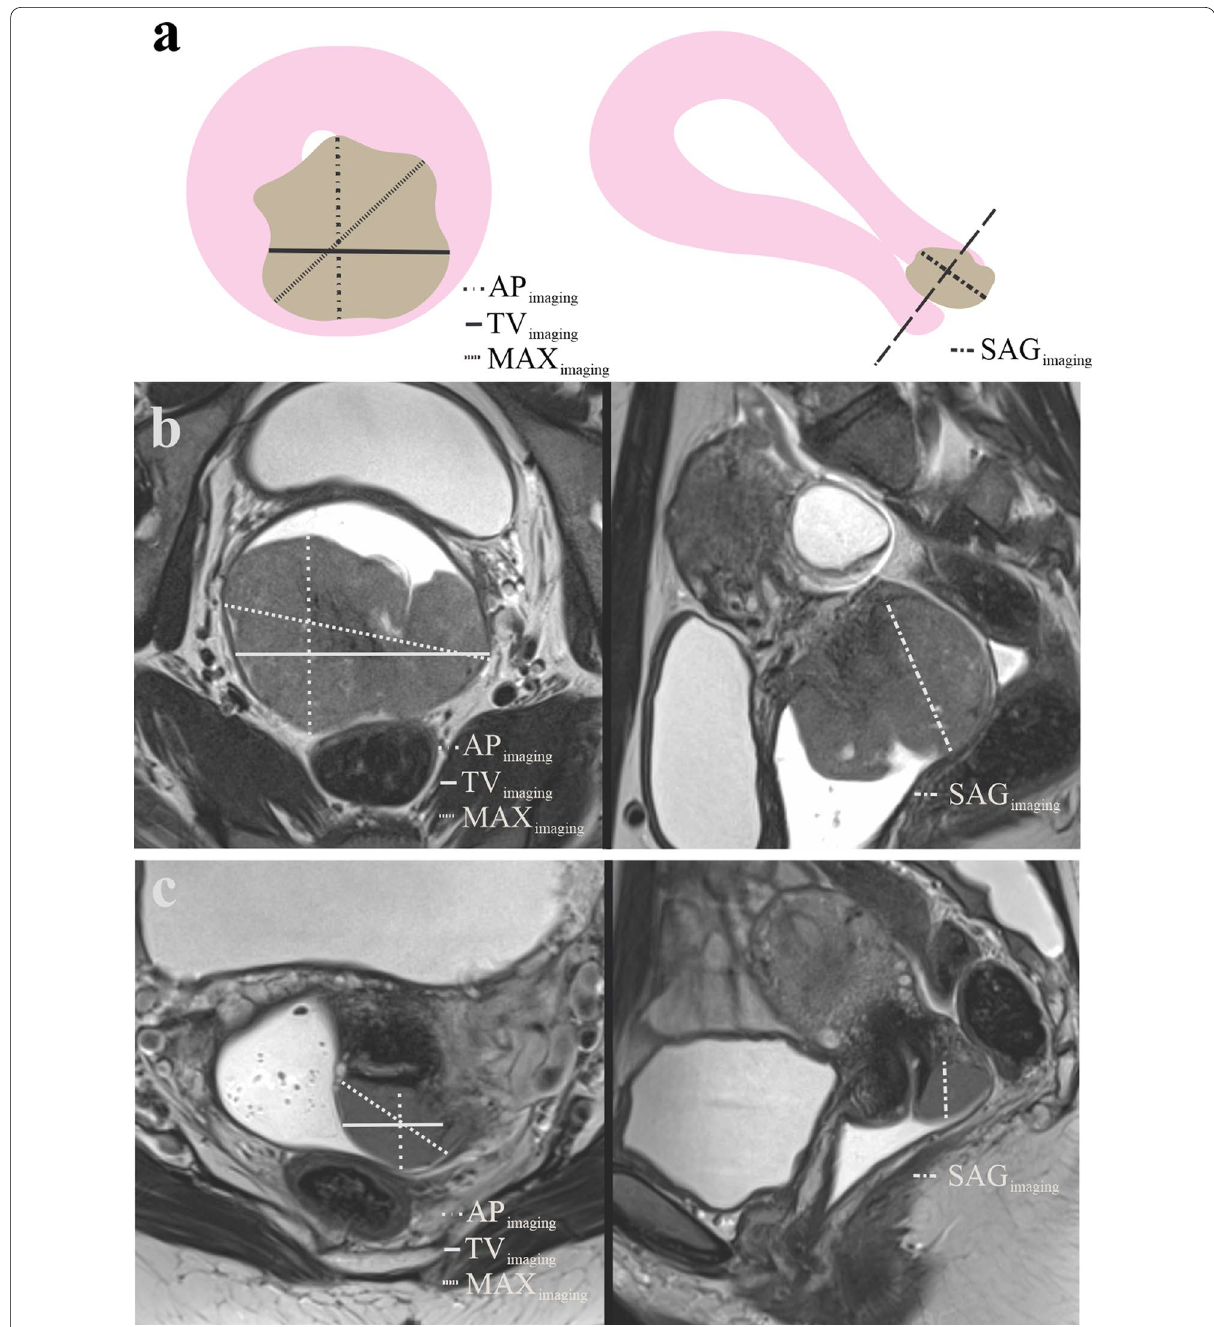
Fig. 2 Graphical illustration of the uterus ( a ) in the axial oblique (perpendicular to the long axis of the cervix; left) and sagittal plane (right) with a tumor (brown) invading the cervical stroma but confined to the uterine cervix. T2‑weighted MRI in the same planes in a 37‑year‑old patient (FIGO 2018) stage IB2 squamous cell carcinoma ( b ) and a 23‑year‑old patient (FIGO 2018) stage IIB squamous cell carcinoma ( c ) depicts hyperintense cervical tumors. Tumor size was measured as the largest anteroposterior (AP imaging ) and transverse (TV imaging ) diameters in the axial oblique plane, largest diameter parallel to the long axis of the cervical lumen in the sagittal plane (SAG imaging ) and maximum tumor diameter (MAX imaging ) irrespective of the